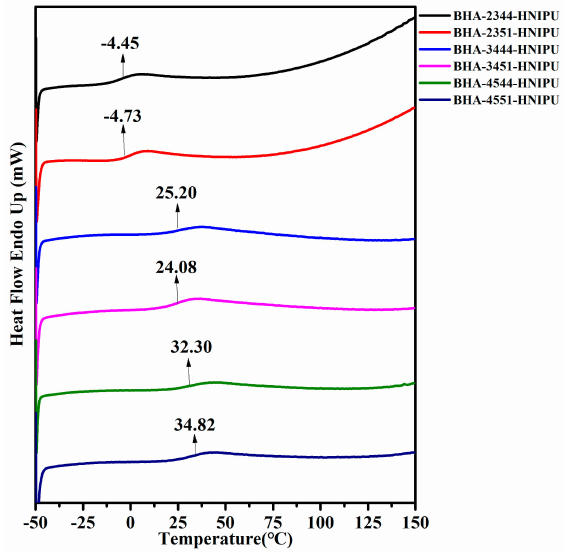
Figure 10. DSC curves of